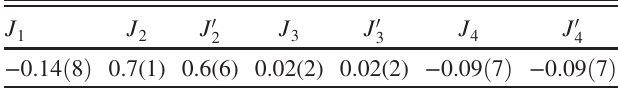
TABLE III. Renormalized exchange interactions used in the linear spin-wave model in units of meV, bonds are labeled according to Fig. 5. The values reported here are renormalized by the reduced ordered moment Z ¼ h m i =gS ¼ 1 . 76 = 4